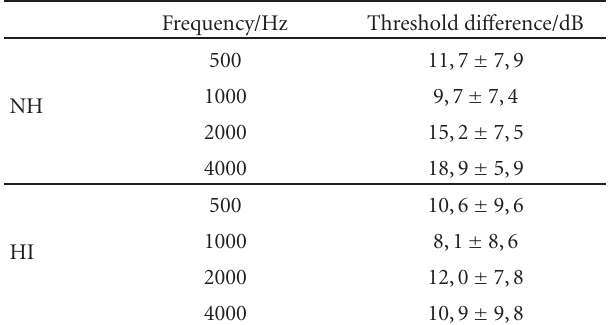
Table 1: Di ff erences between multiple ASSR thresholds and be- havioural pure-tone thresholds for the normal-hearing (NH) and hearing-impaired (HI) test group (means and standard deviations, data from both ears